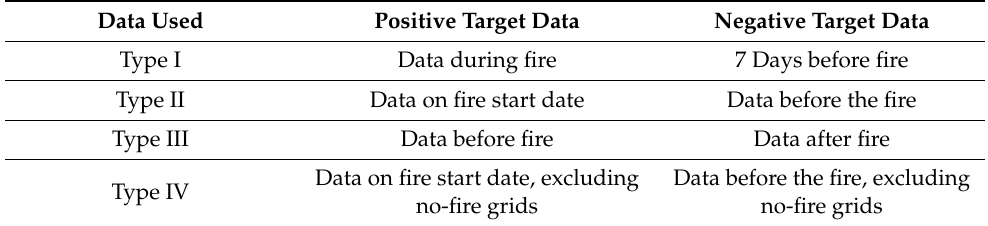
Table 3. Variation of dataset for model building and